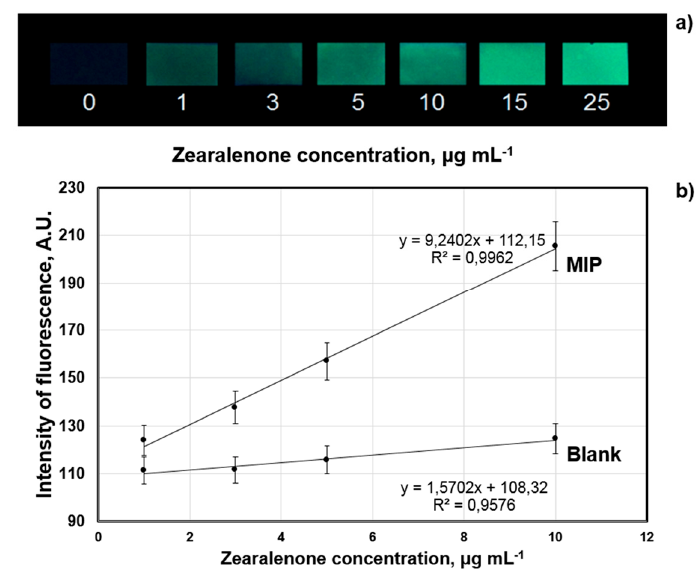
Figure 8. Digital images of the MIP membranes fluorescence after incubation in zearalenone-containing (1–25 µg mL − 1 ) aqueous samples ( a ). Typical calibration plot of the MIP-membrane-based smartphone sensor system for zearalenone detection: smartphone sensor response generated by MIP and blank polymeric membranes as a function of zearalenone concentration registered by Spotxel ® Reader smartphone application (Sicasys Software GmbH, Heidelberg, Germany) ( b ).